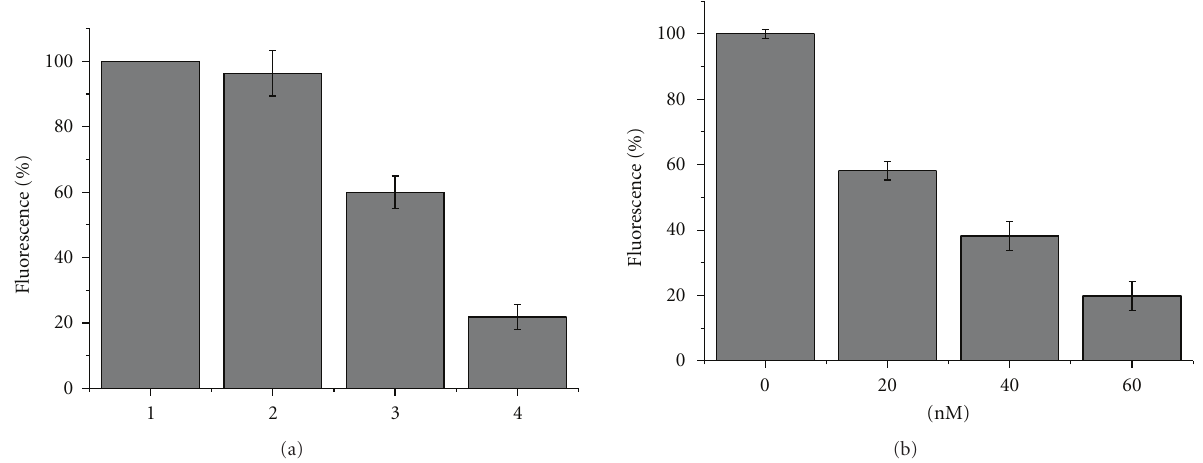
Figure 5: Fluorescence intensity of the real-time hAGT assay, measured at excitation and emission wavelengths of 485 nm and 535, respectively. (a) Illustration of the di ff erent controls with 5nM MB-5-O 6 -MeG-TBA: (1) Positive control of MB-5-O 6 -MeG-TBA in the absence of hAGT; (2) Intensity in presence of the inactive mutant hAGT-C145S; (3) Decrease in fluorescence when adding 40nM active hAGT; and (4) basal fluorescence of 5nM of MB-TBA. (b) Decrease in intensity caused by the activity of hAGT at a range of concentrations (0, 20, 40, and 60nM), in all of them the basal fluorescence of MB-TBA was